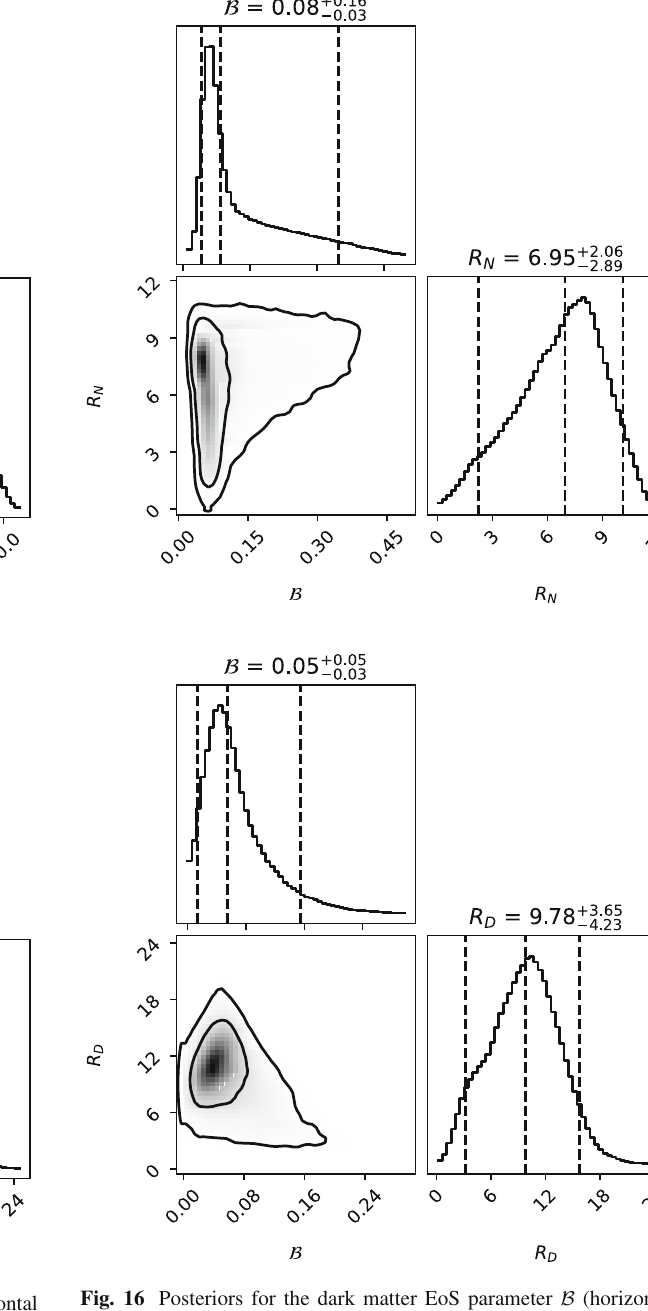
Fig. 15 Posteriors for the dark matter EoS parameter B (horizontal axis) of the SIDM and the core-radius r W (vertical axis) for the first (top sub-figure) and the second (bottom sub-figure) scenarios with neutron APR4 EoS. The inferred best-fitted values of B and r W are also given in Table 2 r W = [ 0 , 25 ] , we obtain the density plots of ( B , r W ) on the ( M , Λ) -plane of the hybrid star configurations of scenario I ( r W = R N ) and II ( r W = R D ) as shown in Fig. 13, for the SLy4 case (other cases are similar). Based on the density plot we can further obtain the corresponding evidence region and the marginal distributions of B and r W , with different choices of neutron EoS: SLy4, APR4 and SKb. The results are shown